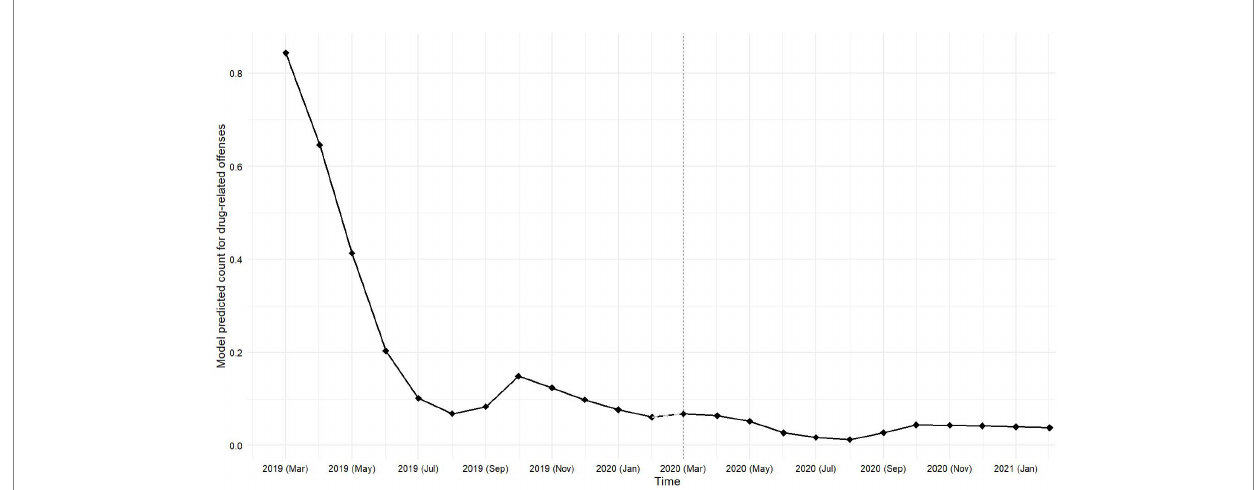
FIGURE 4 Model predicted count for drug-related offenses prior to, at, and following the COVID-19 pandemic by taking seasonality into account. The X-axis represents months prior to (April 2019 to February 2020), at (March 2020, the vertical dashed line), and following (April 2020 to February 2021) the school closures. Y-axis represents the model predicted mean count. The dashed vertical line indicates the month when containment measures started to be implemented. The dashed oblique line highlights the abrupt jump in offense count between 1 month before the implementation of the containment measures and the month after implementing these containment